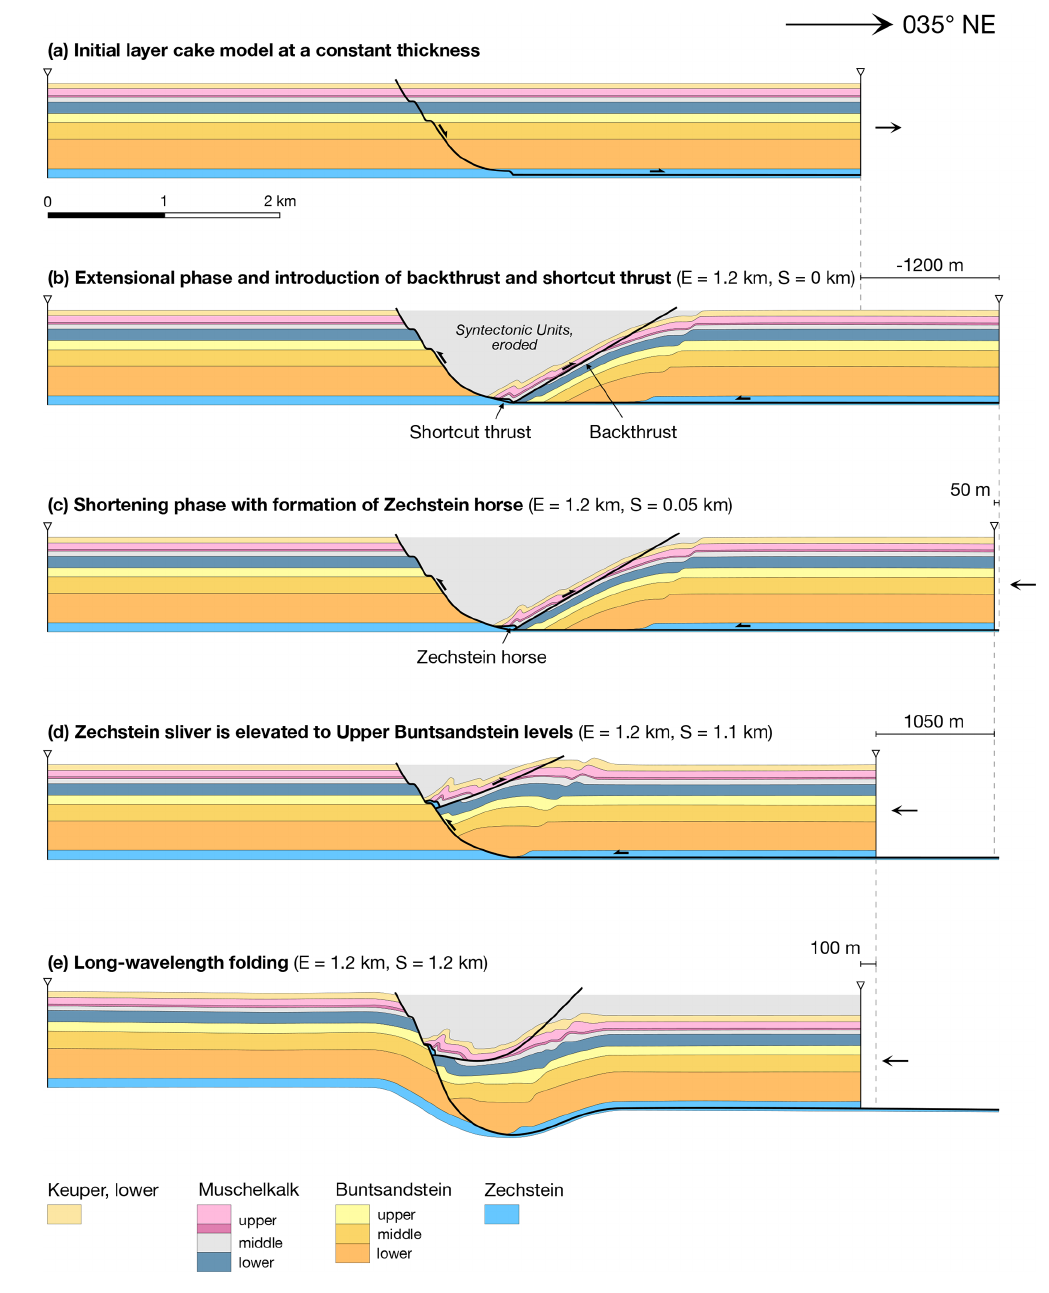
Figure 6. Forward model of the formation of the Sontra Graben. Stratigraphic thicknesses from Motzka-Noering et al.